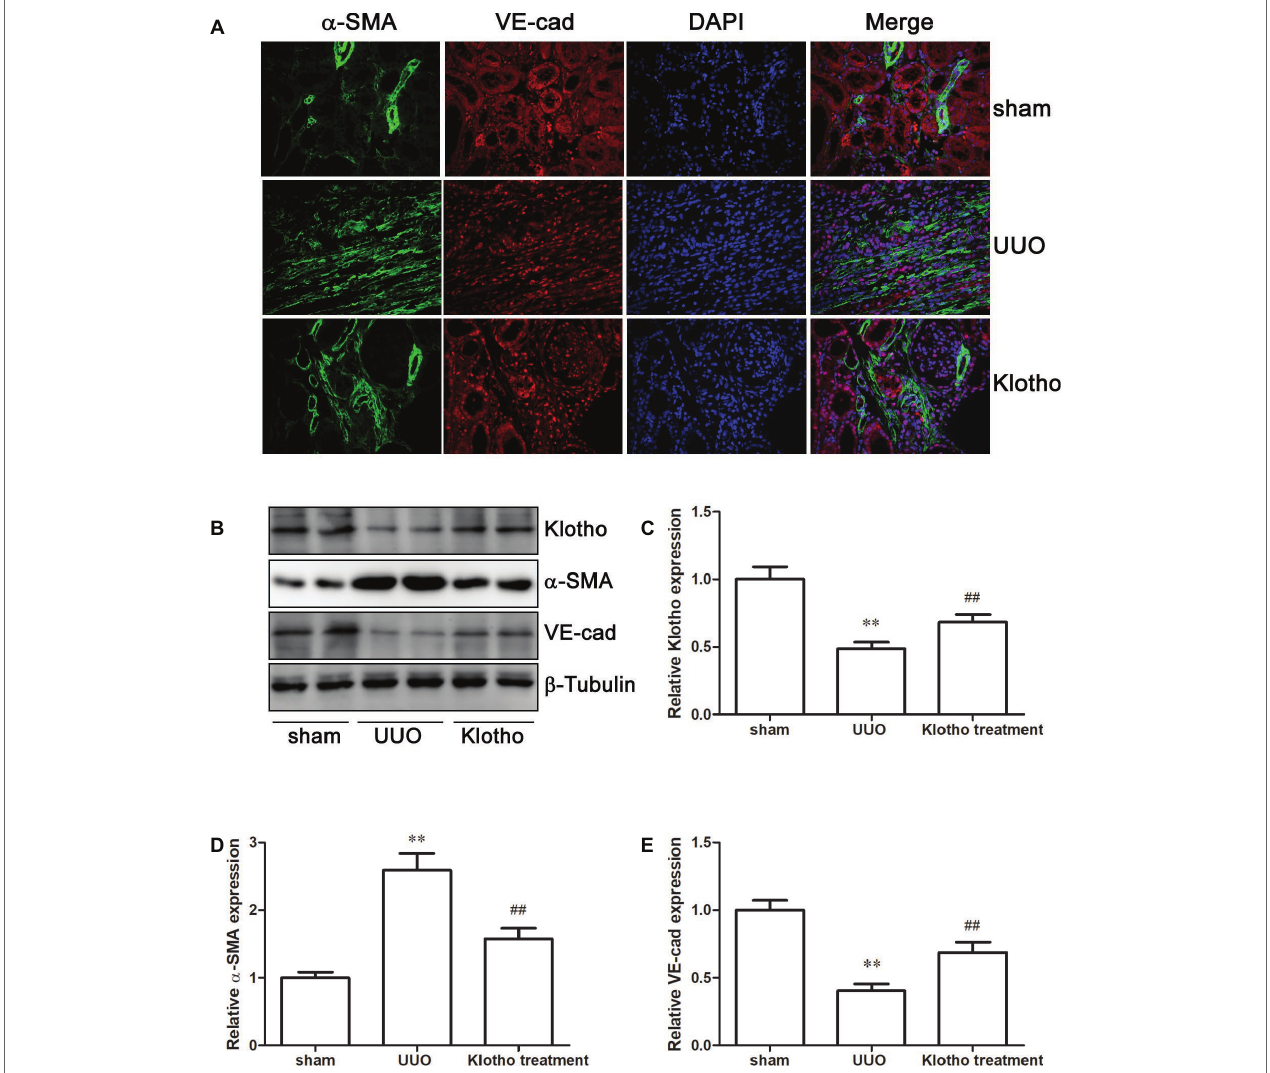
FIGURE 2 | Klotho administration reversed EndoMT process in UUO mice. (A) Immunofluorescence staining demonstrates α -SMA (green), VE-cad (red), and DAPI (blue) in experimental groups. (B) Representative western blotting image of Klotho, α -SMA, and VE-cad expression in experimental groups. β -Tubulin expression was analyzed as an endogenous control. Densitometric analysis was performed for quantification of the bands of Klotho (C) , α -SMA (D), and VE-cad (E) . ** p ≤ 0.01 versus sham group; ## p ≤ 0.01 versus UUO